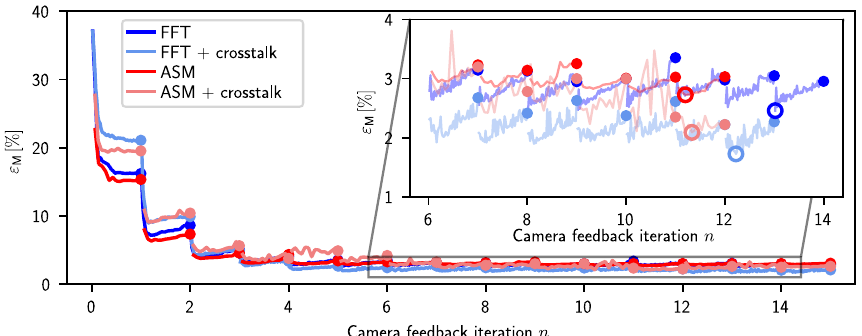
Figure 4. Convergence of the feedback procedure using the FFT and the ASM, with and without pixel crosstalk modelling. The main figure shows ε M as it converges for n = 15 camera iterations with m = 100 CG iterations in between. The values ε M used in the camera feedback process are shown as filled circles. To investigate the behaviour of ε M during the CG minimisation, we saved intermediate phase patterns and analysed the resulting light potentials (lines in main figure). For n > 1 , the experimental error, ε M , is smallest for m < 100 . The inset shows the convergence during the final 8 camera feedback iterations. The lowest experimental error was found between n = 11 and n = 14 (hollow circles in the